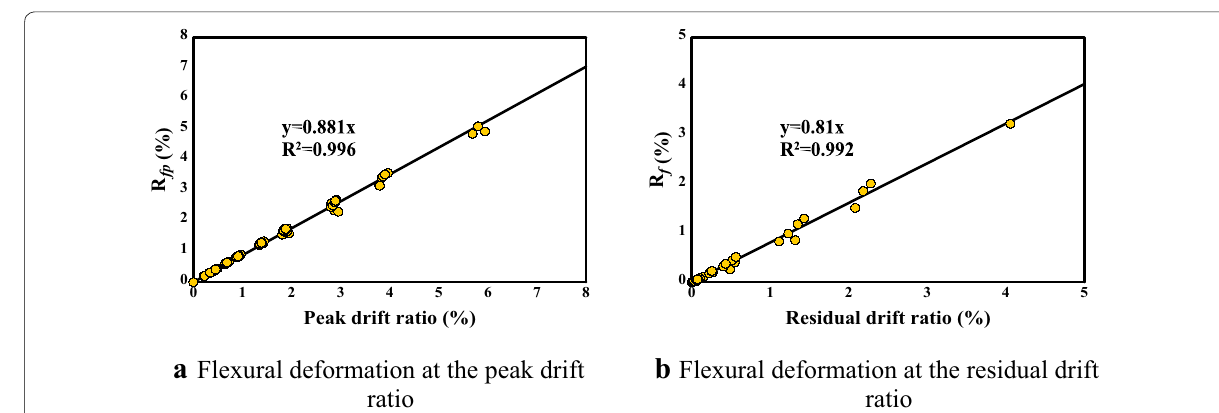
Fig. 11 Specimen of SF‑30S‑0.1 and SF‑30S‑0.2.